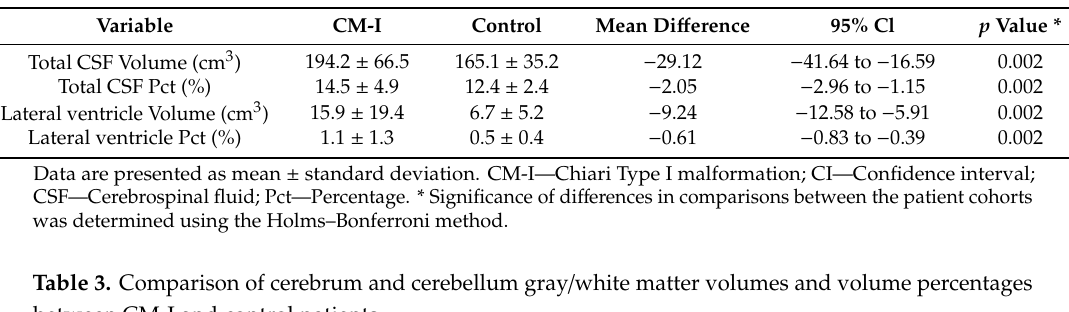
Figure 2. ( A ) The statistical di ff erences of cerebrum gray matter volume percentages (%) between CM-I group (44.0 ± 5.3) and control group (46.1 ± 3.3) are shown ( p = 0.002). ( B ) The statistical di ff erences of cerebrospinal fluid volume percentages (%) between CM-I group (14.5 ± 4.9) and control (12.4 ± 2.4) are shown ( p = 0.002). ( C ) The statistical di ff erences of lateral ventricle volume percentages (%) between CM-I group (1.1 ± 1.3) and control group (0.5 ± 0.4) are shown ( p = 0.002). ( D ) The statistical di ff erences of lateral ventricle volume (cm 3 ) between CM-I group (15.9 ± 19.4) and control group (6.7 ± 5.2) are shown ( p = 0.002). Table 2. Comparison of total cerebrospinal fluid and lateral ventricle volumes and volume percentages between CM-I and control patients.